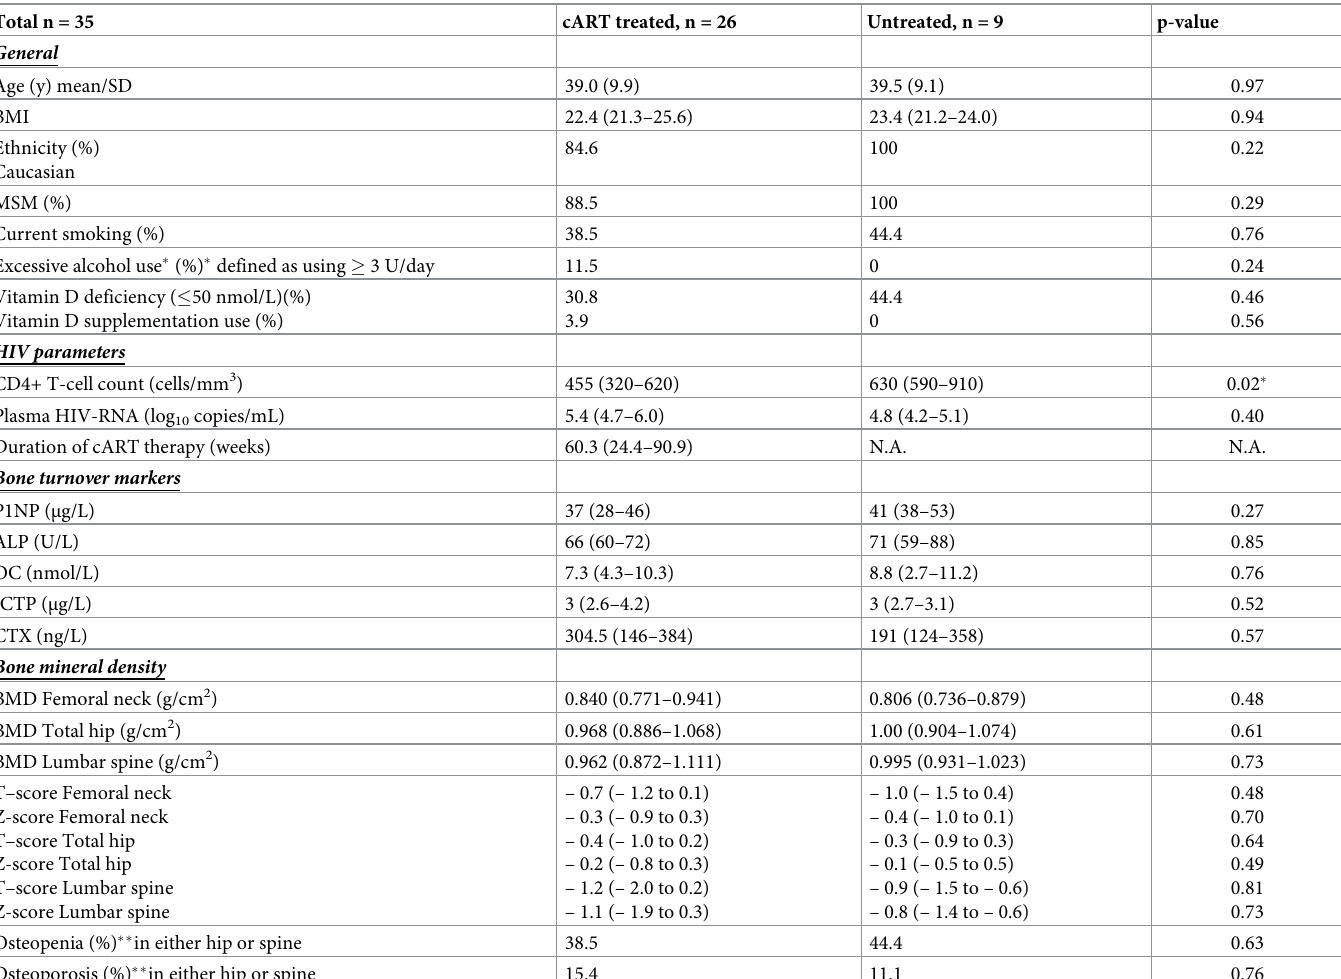
Table 1. Baseline results of